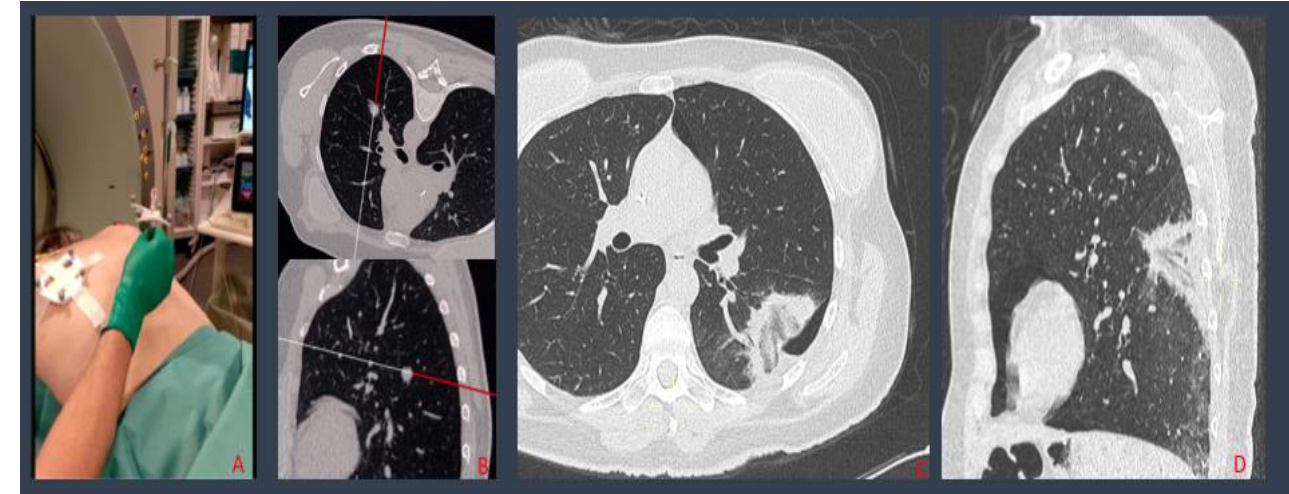
Figure 1. Percutaneous lung MW ablation of a breast cancer metastasis: needle and patient tools positioning ( A ); the navigation system, creating a 3D virtual model of the patient’s chest, where needle progressions into the patient’s chest are shown ( B ); post procedural MPR CT reconstructions displaying a small PNX adjacent to the ablation zone, without evidence of residual disease ( C , D ).